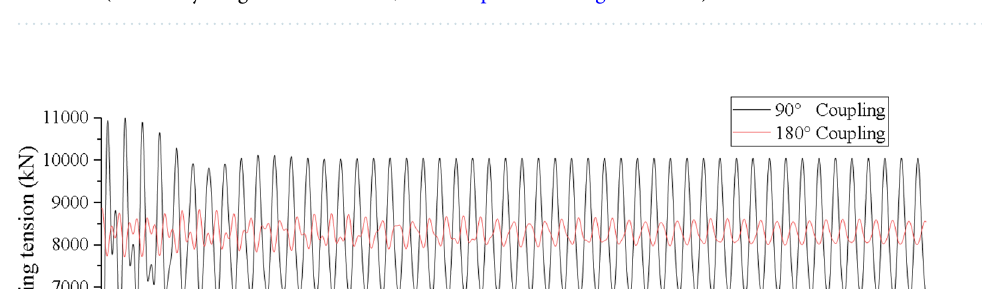
Figure 12. Heave amplitude and pitch amplitude of mining vessel with or without lifting pipe under different sea states (created by Origin 2017 software, URL: https:// www. origi nlab. com/).